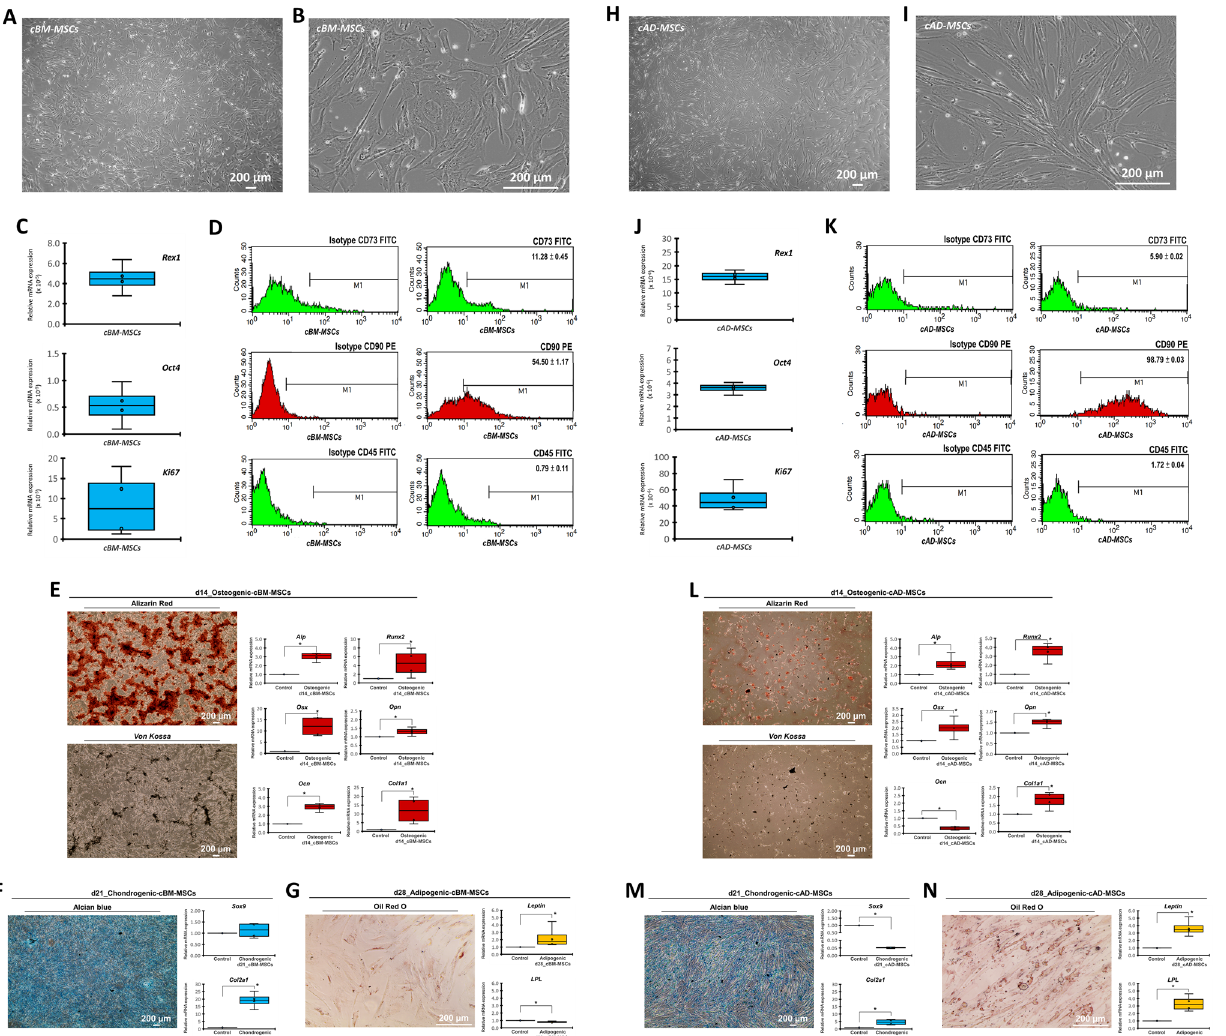
Figure 1. cBM-MSC and cAD-MSC characterization. Morphological appearances of cBM-MSCs ( A , B ) and cAD-MSCs ( H , I ) were observed under phase-contrast microscope with magnification of 40X and 200X. mRNA expressions regarding stemness and proliferation markers ( C , J ) were determined by RT-qPCR. mRNA expression was normalized with a reference gene. The MSC-related surface markers were analyzed using flow cytometry ( D , K ). Osteogenic differentiation potential at day 14 post-induction was determined by Alizarin Red S and Von Kossa staining, and the osteogenic mRNA marker expression was analyzed by RT-qPCR ( E , L ). Chondrogenic differentiation potential at day 21 post-induction was determined by Alcian blue staining, and chondrogenic mRNA markers were determined ( F , M ). Adipogenic differentiation potential at day 28 post- induction was determined by Oil Red O staining, and adipogenic mRNA markers were determined ( G , N ). mRNA expression was normalized with a reference gene and undifferentiated control. Bars indicate a significant difference (*, p value <